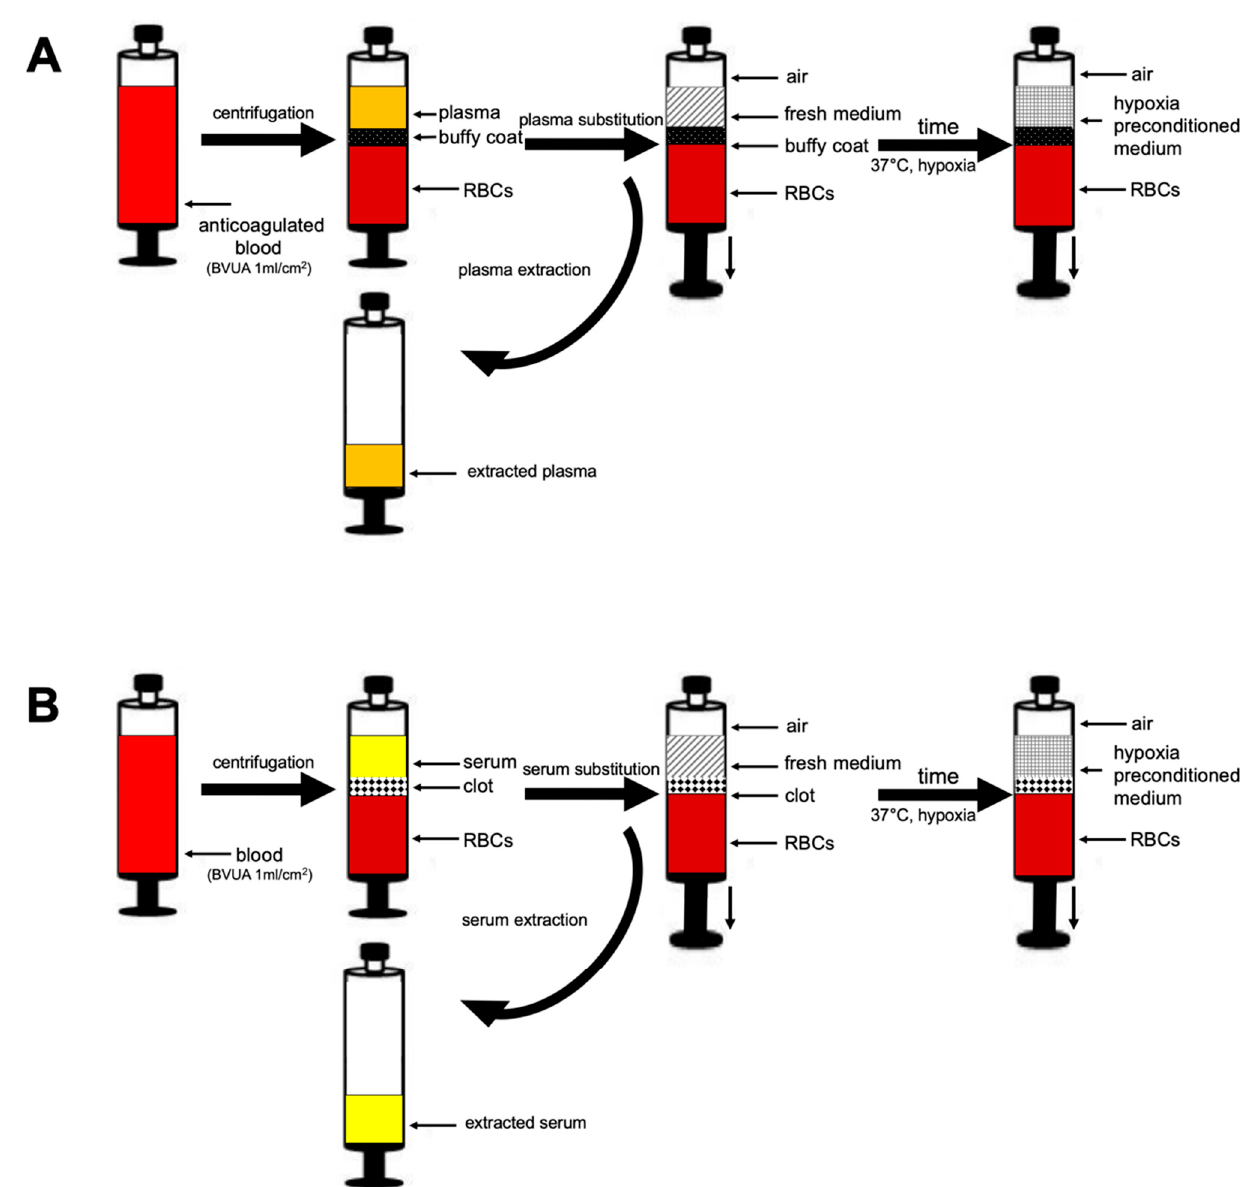
Figure 6. Preparation of hypoxia preconditioned samples through plasma and serum substitution. Preparation of fresh plasma ( A ) and serum ( B ). After centrifugation, the blood was separated into three layers, from bottom to top: red blood cell component (RBCs), buffy coat/clot, and plasma/serum, so that the top layer (plasma or serum) could be extracted into a new syringe. The same volume was then substituted in each case by saline (NaCl 0.9%), Phosphate buffered saline (PBS), Glucose 5% (G-5%), or AIM V serum-free medium (AIM V serum free), and 5 mL of air was drawn into the syringe through the filter and preconditioned under pericellular (local) hypoxia (~1% O 2 ) and physiological temperature (37 °C) for 2 to 8 days. After the predefined incubation time, the growth factor-enriched hypoxia preconditioned medium (HPP/HPS-NaCl/-PBS/-G-5%/ -AIM) was separated by filtering into a new syringe, removing cells/cellular debris.